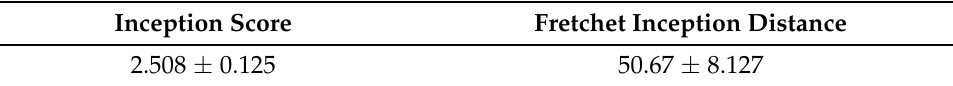
Figure 9. Some synthetic images that were generated using the present approach. ( a ) Synthetic images belonging to the COVID-19 infected CXR class generated by the GAN; ( b ) synthetic images belonging to the normal CXR class generated by the GAN. Table 4. The inception score and the Fretchet inception distance for the images that were generated by the